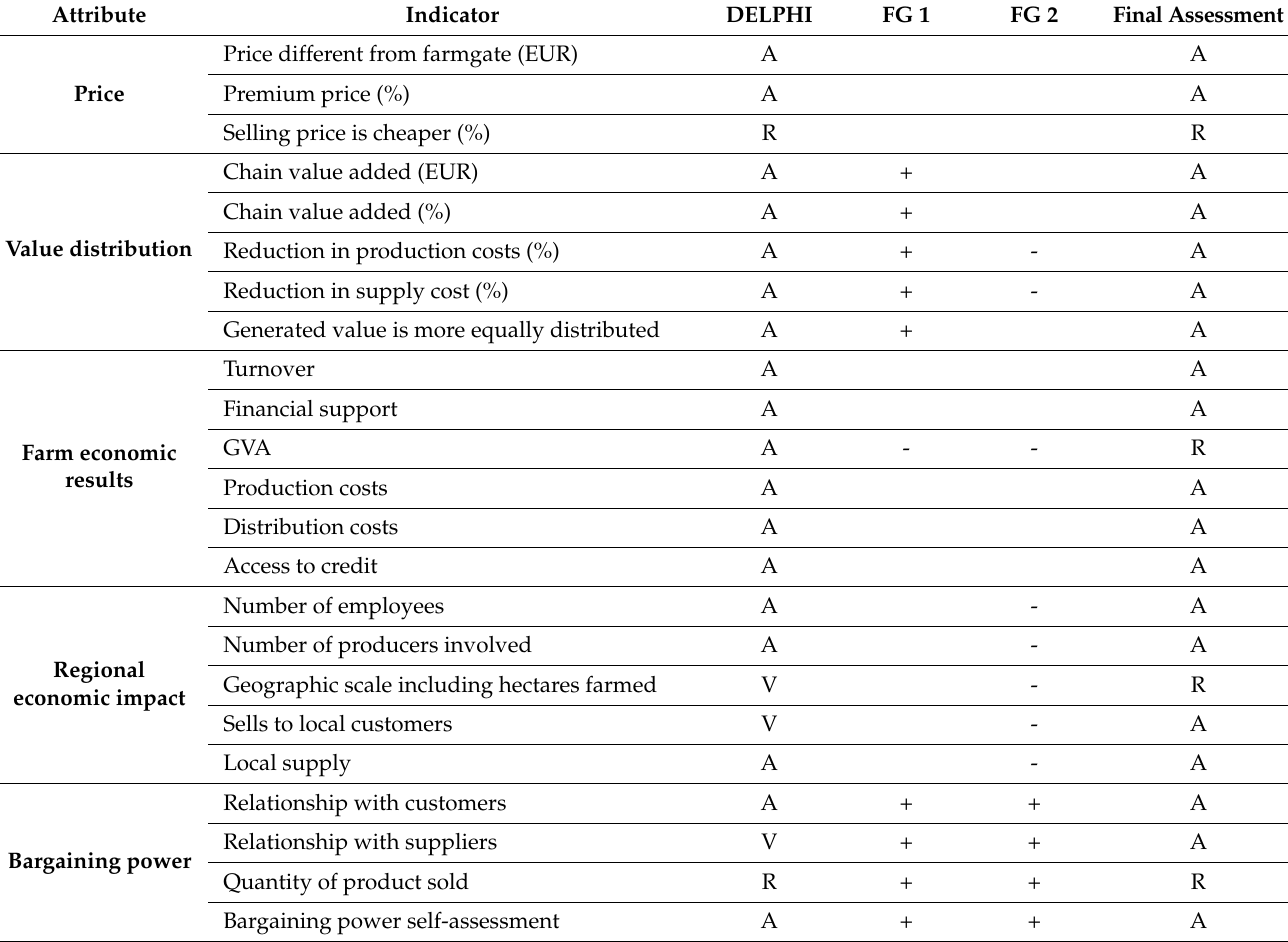
Table 2. Initial results of economic attributes and indicators.